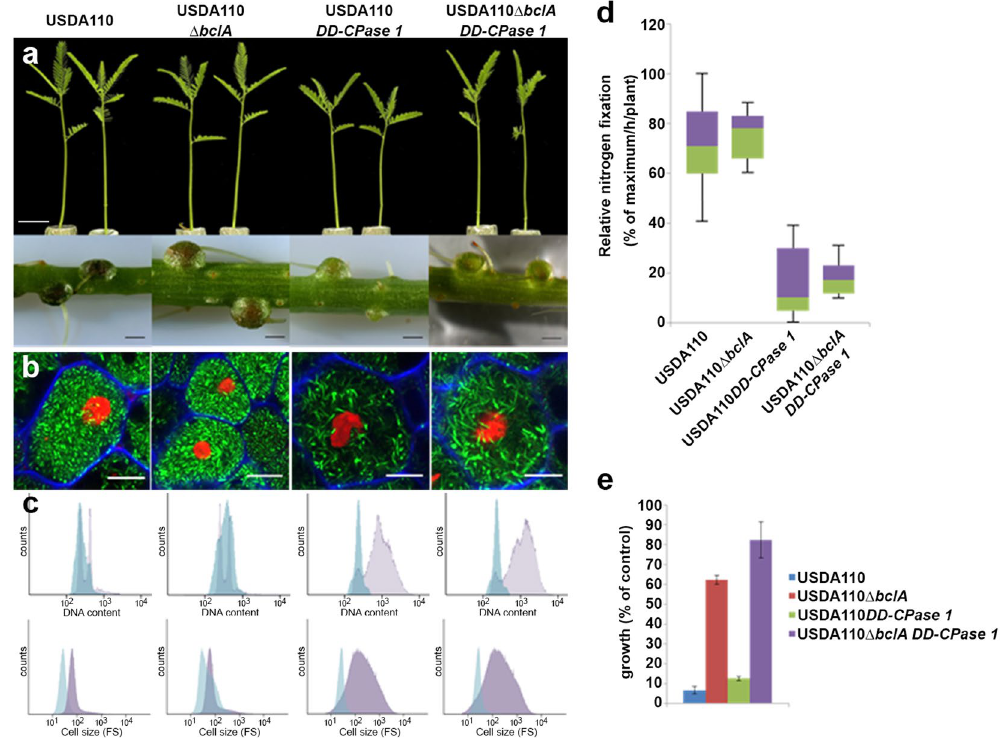
Figure 5. The B. diazoefficiens bclA , DD-CPase1 , bclA/DD-CPase1 mutant phenotypes in symbiosis with A. afraspera . ( a ) Plant growth and nodule phenotype of A. afraspera plants inoculated with B. diazoefficiens USDA110 wild type and indicated mutants at 14 dpi. Scale bars are 2 cm (top panels) and 1 mm (bottom panels). ( b ) Confocal microscopy of bacteroid viability determination by live/dead and calcofluor white staining of A. afraspera nodules induced by USDA110 wild type and indicated mutants. Scale bars are 10 µ m. ( c ) Flow cytometry analysis of DNA content by DAPI fluorescence and of cell size by forward scatter (FS) in free living B. diazoefficiens USDA110 (blue) or bacteroids isolated from A. afraspera nodules infected with USDA110 wild type and indicated mutants (pink). ( d ) Relative nitrogen fixation activity (% of maximum/h/plant) of A. afraspera plants inoculated with B. diazoefficiens USDA110 wild type and indicted mutants, measured by the acetylene reduction assay per plant. Box-plots represent in the rectangle the first quartile to the third quartile, divided by the median value, whiskers above and below the box show the minimum and maximum measured values. ( e ) Bleomycin sensitivity in B. diazoefficiens strain USDA110 and its bclA, DD-CPase1 ,